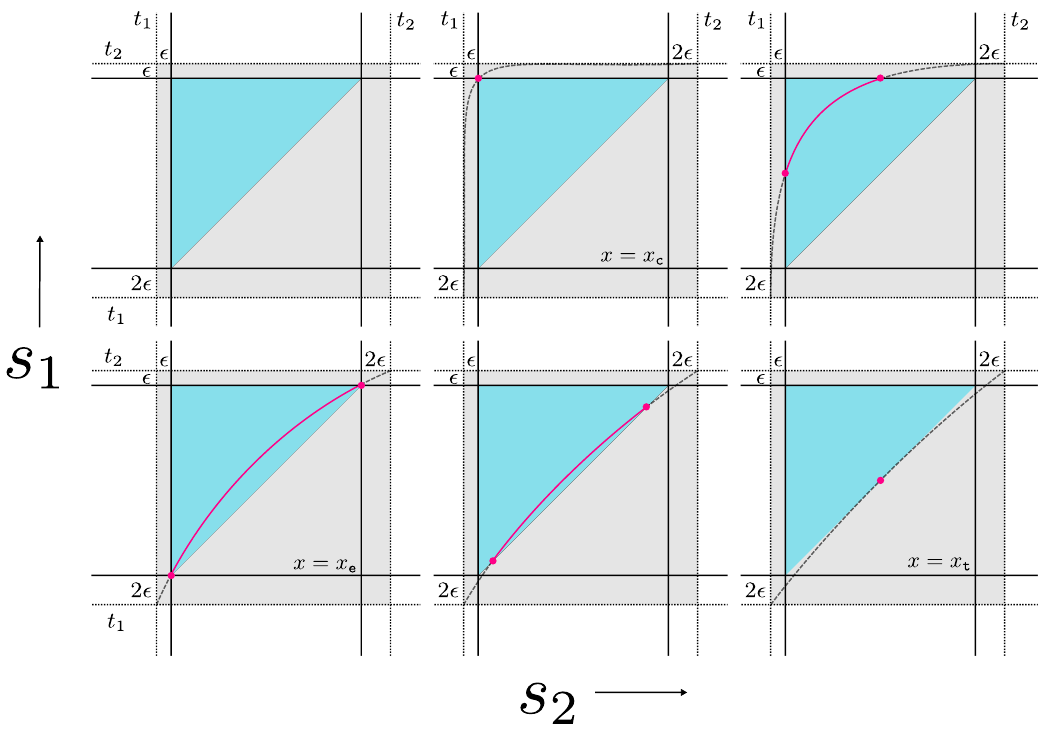
Figure 5 . The integration range in the ( s 1 , s 2 ) plane, (C.11), is denoted by the shaded upper triangular region in blue. For a given fixed value of the cross ratio x , ( s denoted by the pink arcs in the panels above. The intersection points of C region (C.11) determine the limits of the s